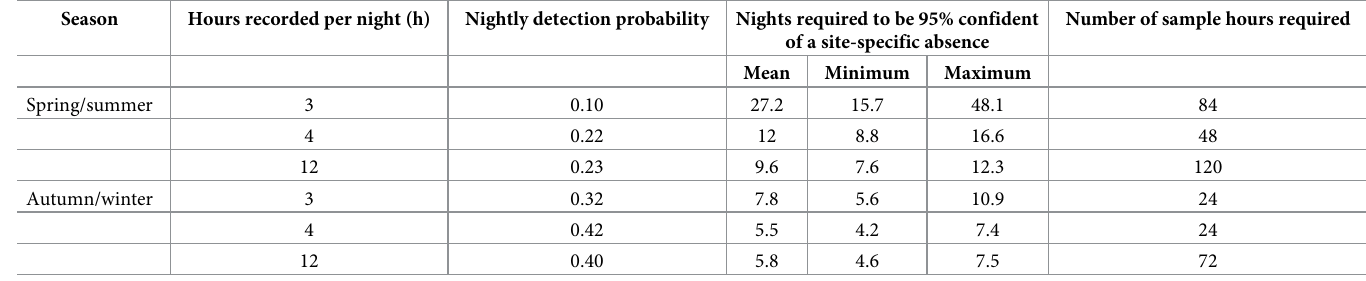
Estimates assume that recording starts at the beginning of the hour that includes